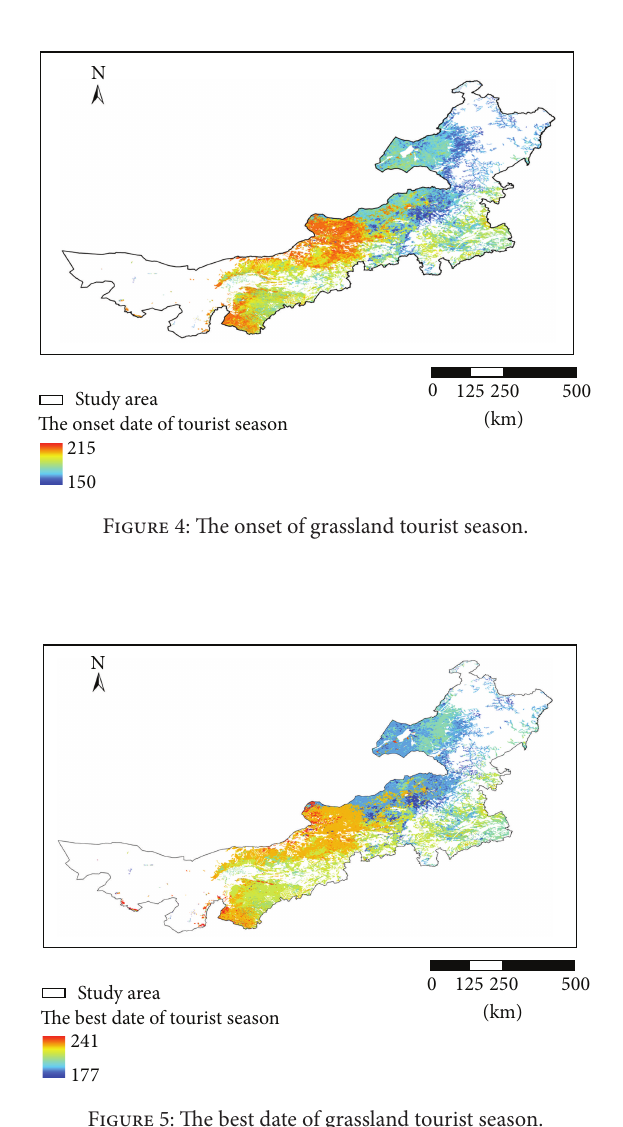
Figure 5: The best date of grassland tourist season.